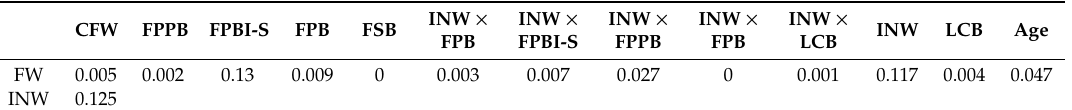
Table 7. E ff ect sizes (f 2